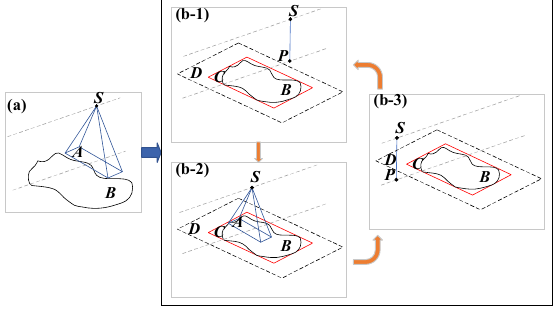
Figure 1. Optimization of the area coverage algorithm